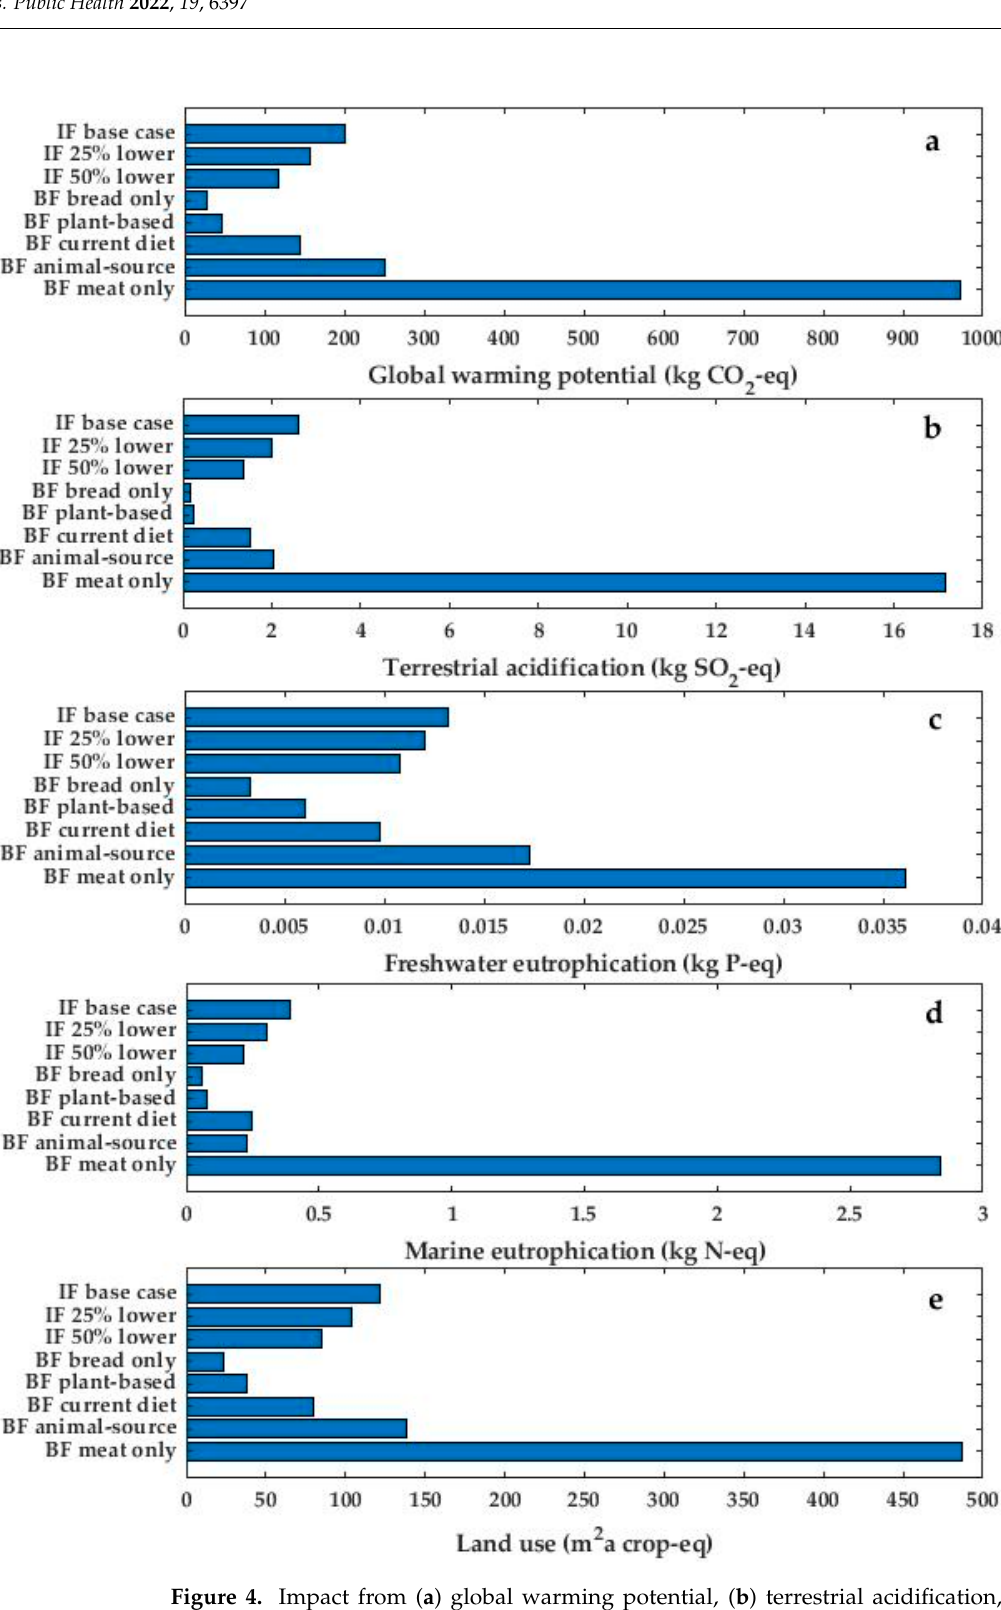
Figure 4. Impact from ( a ) global warming potential, ( b ) terrestrial acidification, ( c ) freshwater eutrophication, ( d ) marine eutrophication, and ( e ) land use, from four months feeding of infant formula base case and with 25% and 50% lower impact from cow milk compared to different dietary scenarios for breastfeeding. IF = infant formula; BF = breastfeeding; IF 25% lower refers to infant formula produced with 25% lower impact from cow milk; and IF 50% refers to infant formula produced with 50% lower impact from cow milk.